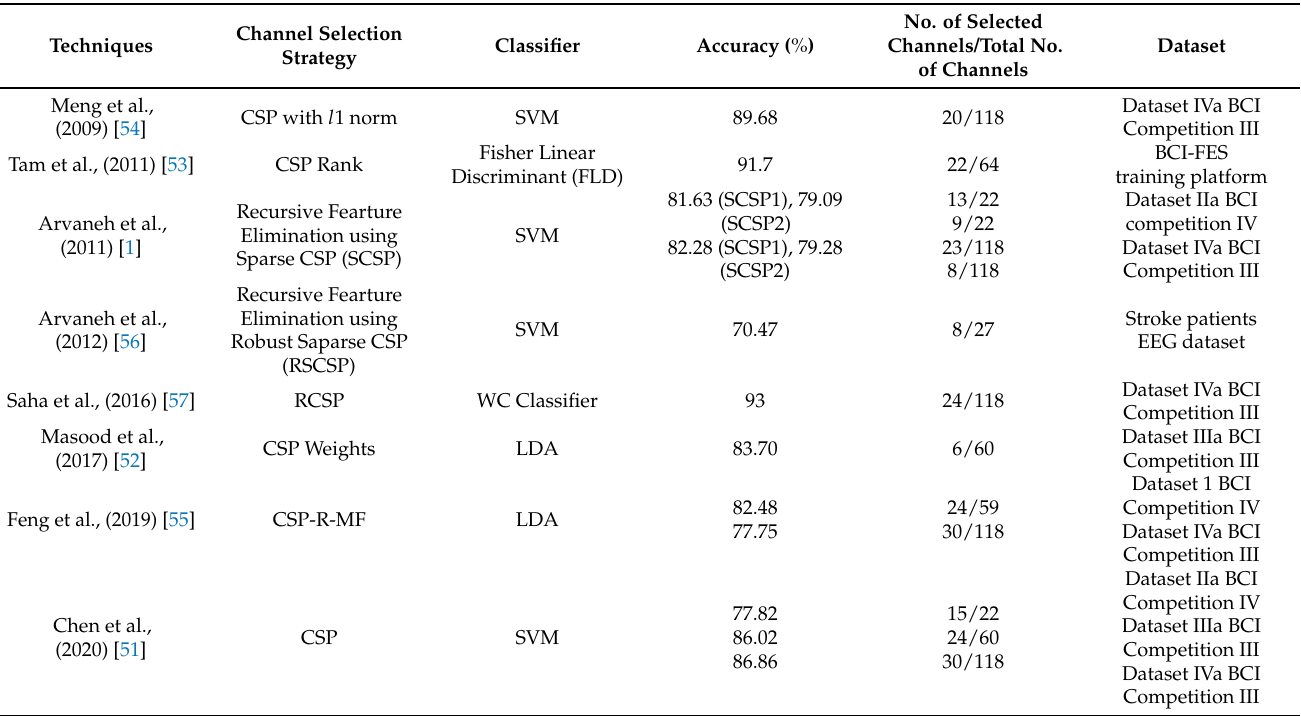
Table 2. Common spatial pattern (CSP)-based techniques for EEG channel selection of motor imagery EEG channel